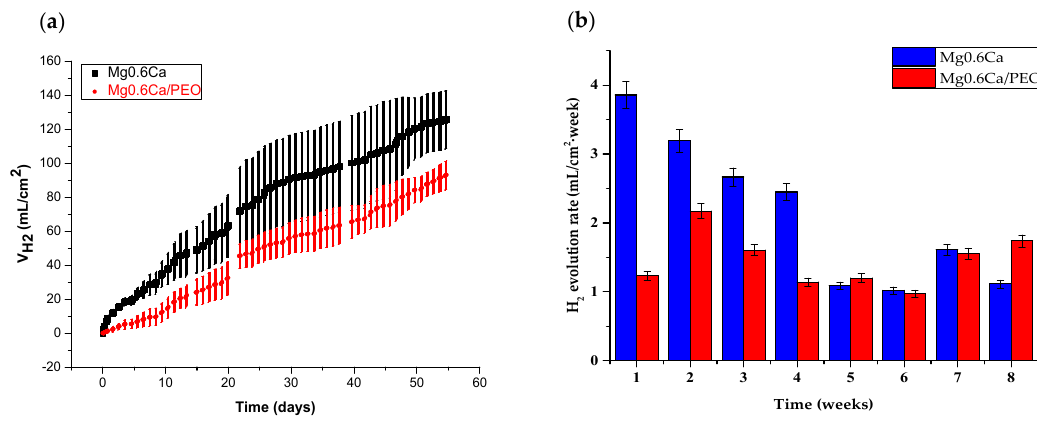
Figure 8. ( a ) Hydrogen volume and ( b ) hydrogen evolution rate of Mg0.6Ca and Mg0.6Ca / PEO after 60 days of immersion in m-SBF.